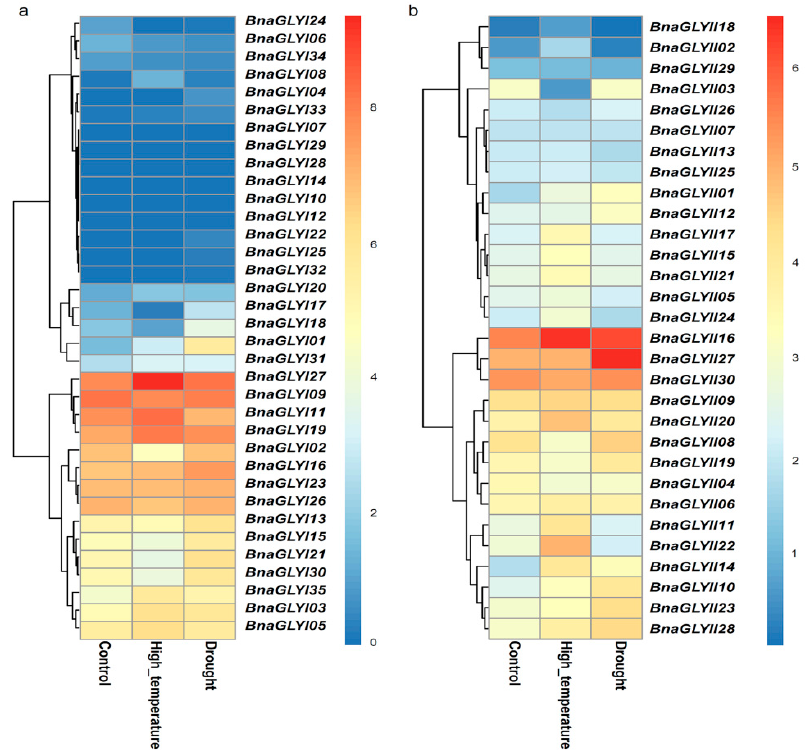
Figure 7. Expression profiles of the BnaGLY genes in response to heat and drought stresses. Relative expression data of available BnaGLYI ( a ) and BnaGLYII ( b ) genes under heat (40 °C, 3 h) and drought (withdrawing water, 3 days) treatment were obtained from NCBI GEO database (GSE156029, https://www.ncbi.nlm.nih.gov/geo/query/acc.cgi?acc=GSE156029, (accessed on 16 December 2022)).